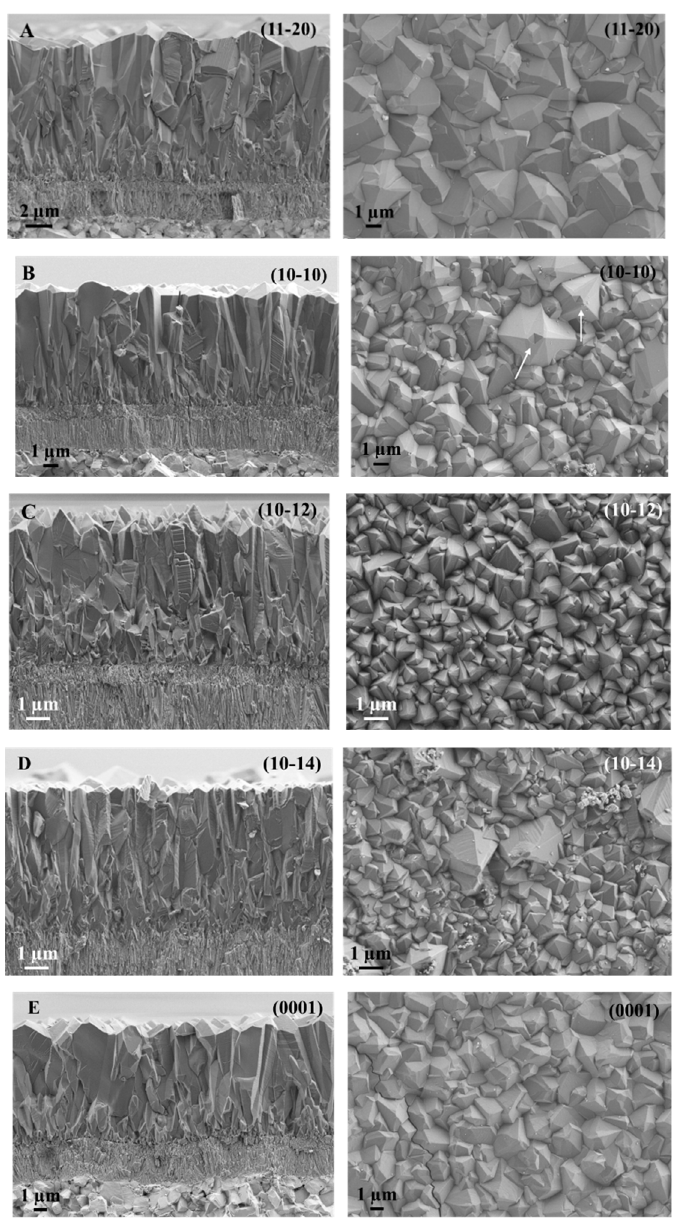
Figure 6. SEM cross sections (on the left) and surface images (on the right) of coatings deposited at H 2 S/CO 2 ratios of the order of ( A ) 0.005, ( B ) 0.013, ( C ) 0.06, ( D ) 0.1 and ( E ) 0.2, respectively. The Σ 3 CLS GB fractions and TCs for the (1120), (1010), (1012) and (0006) α -Al 2 O 3